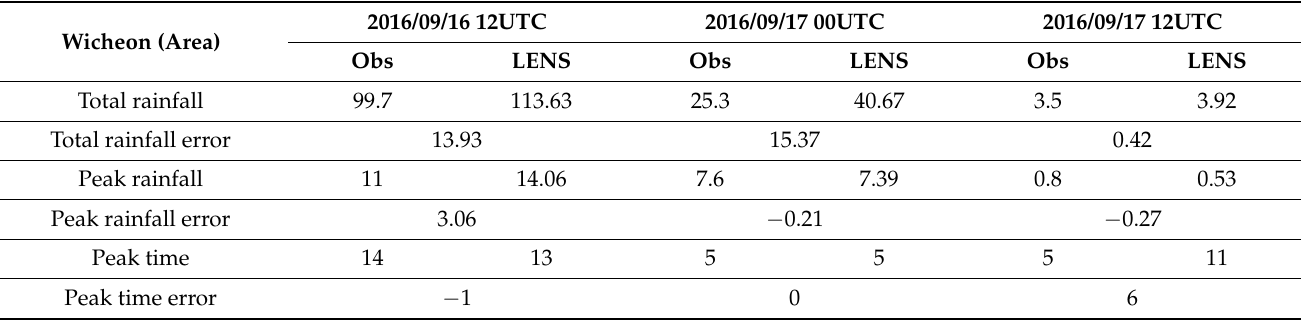
Table 7. LENS area data from 2016/09/16 12UTC to 2016/09/17 12UTC.